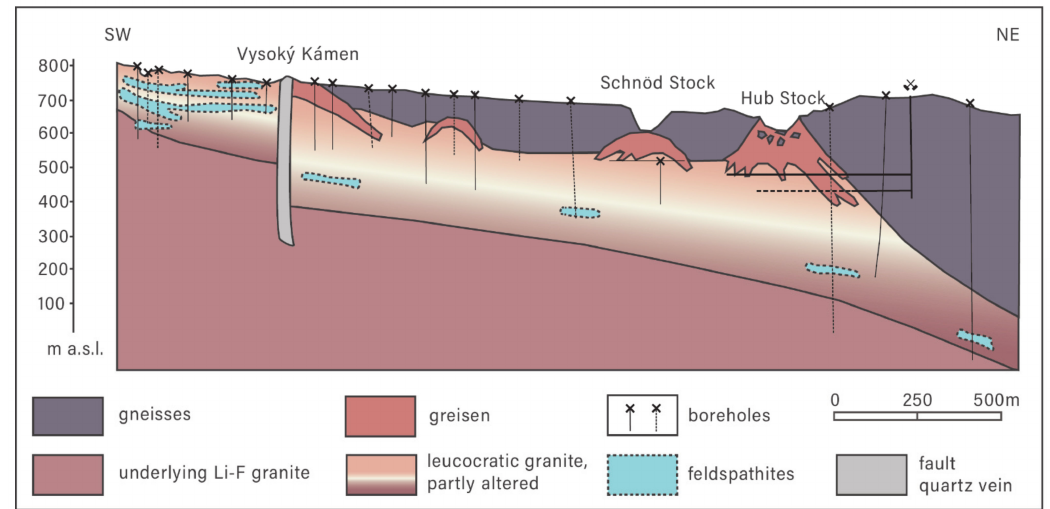
Figure 1. Sketch of Krušn é hory/Erzgebirge Variscan granitic plutons. Studied locality Kr á sno forms part of Krudum body, which is located in the southern margins of the Karlovy Vary pluton (adopted and modified after [35]).